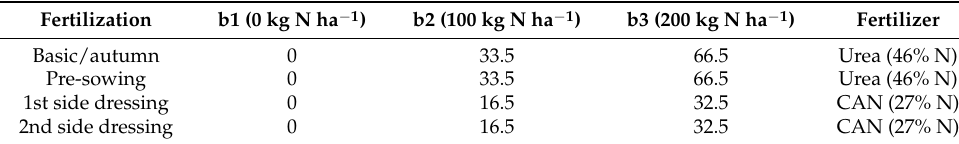
Table 4. Amount and form of N